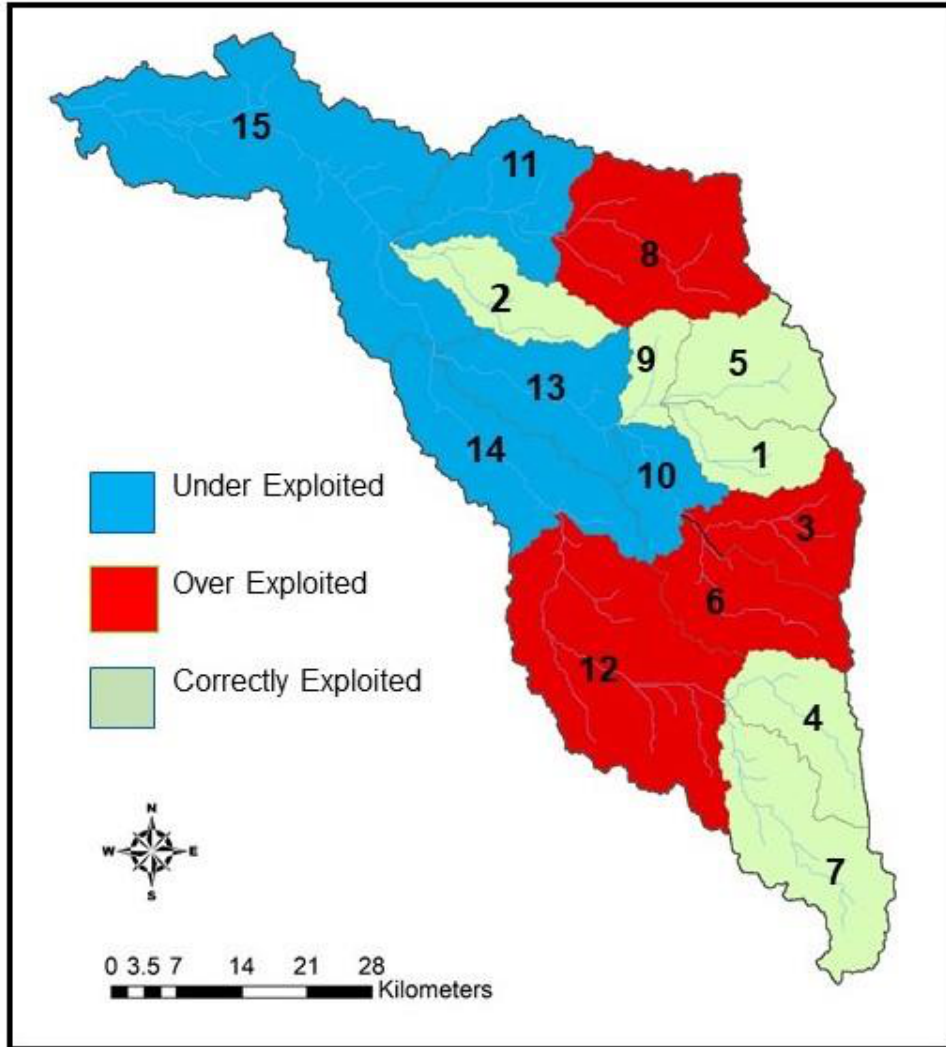
Figure 10. Classification of large sub-basins of Malwatu Oya by their current state of exploitation of surface storage. Sub-basin numbers shown in black. Sub-basin details provided in Table 4. Table 4. Degree of over-/under-exploitation of large sub-basins of Malwatu Oya. Colors blue, red and green correspond to under, over and correct exploitation levels.